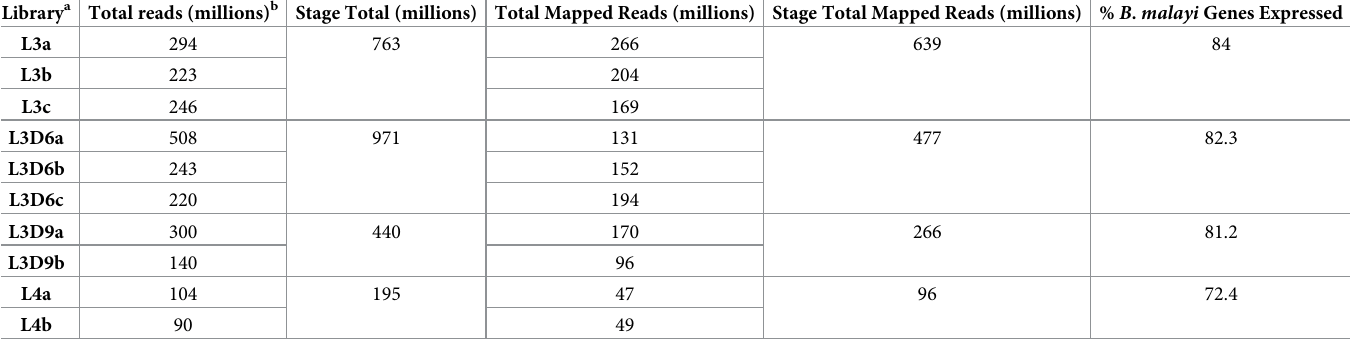
Table 1. RNA-Seq